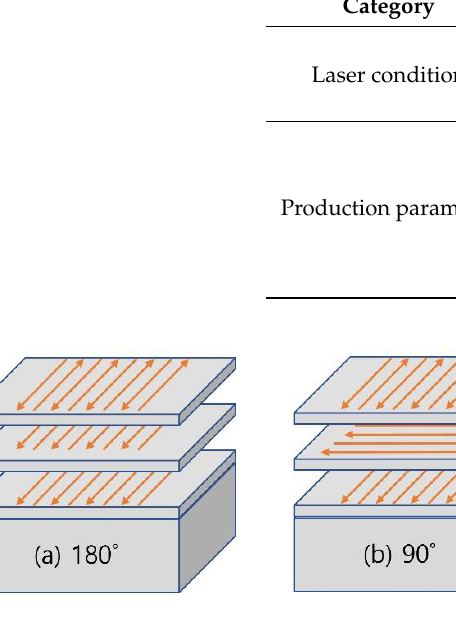
Figure 3. Schematic illustration of SLM simulation [8]: ( a ) Stacking three patterns in the same direction; ( b ) with 90° rotation; ( c ) with 67° rotation; ( d ) with 45° rotation.